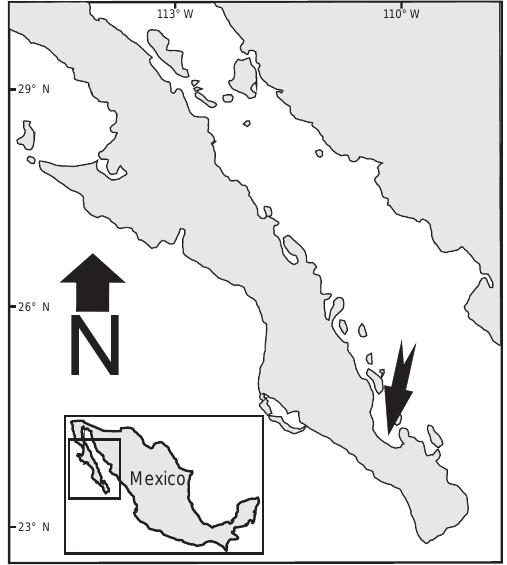
Figure 1. Map showing location of coral sampling site in Bahía de La Paz,